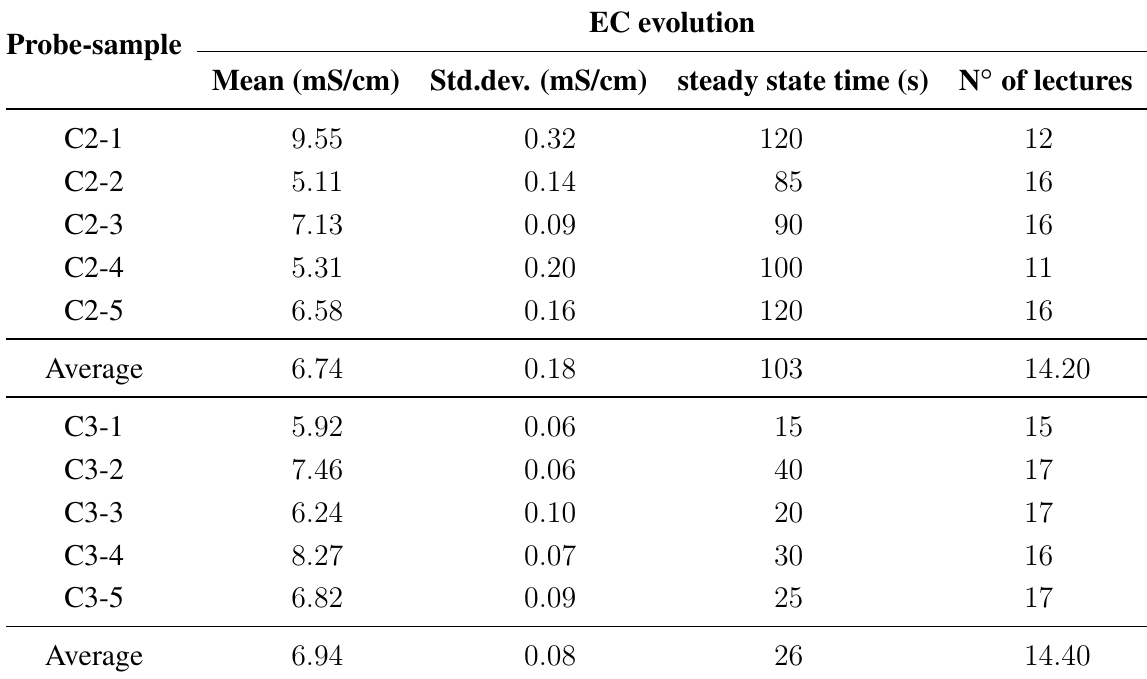
Table 5. EC dynamics in C2 and C3 probes at on-line testbed